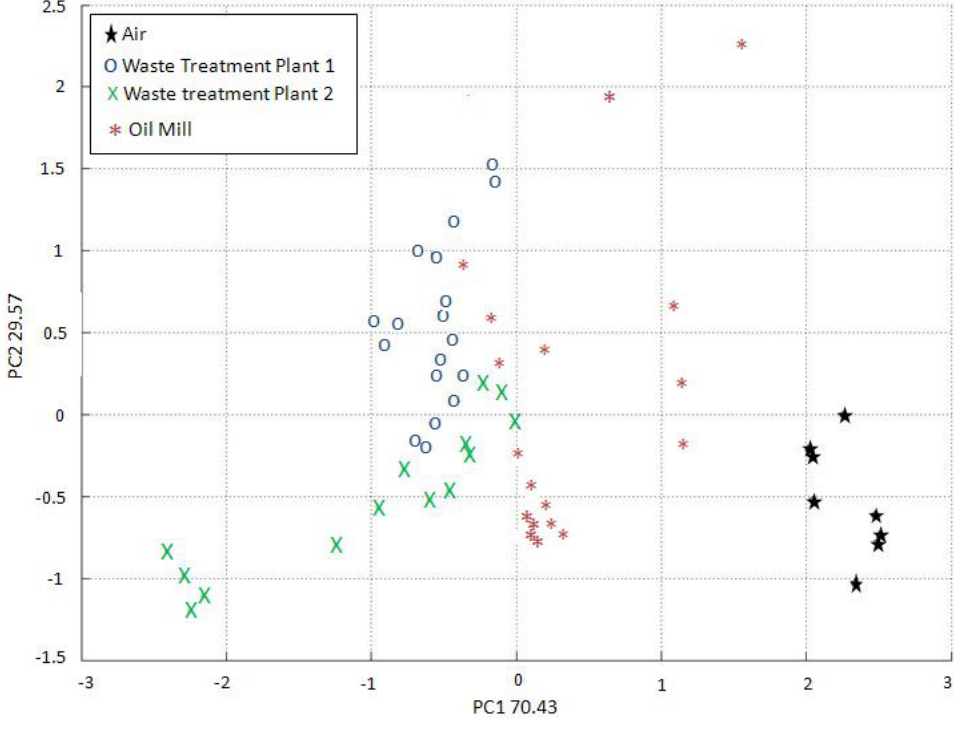
Figure 10. PCA of the EOS 835 training data.